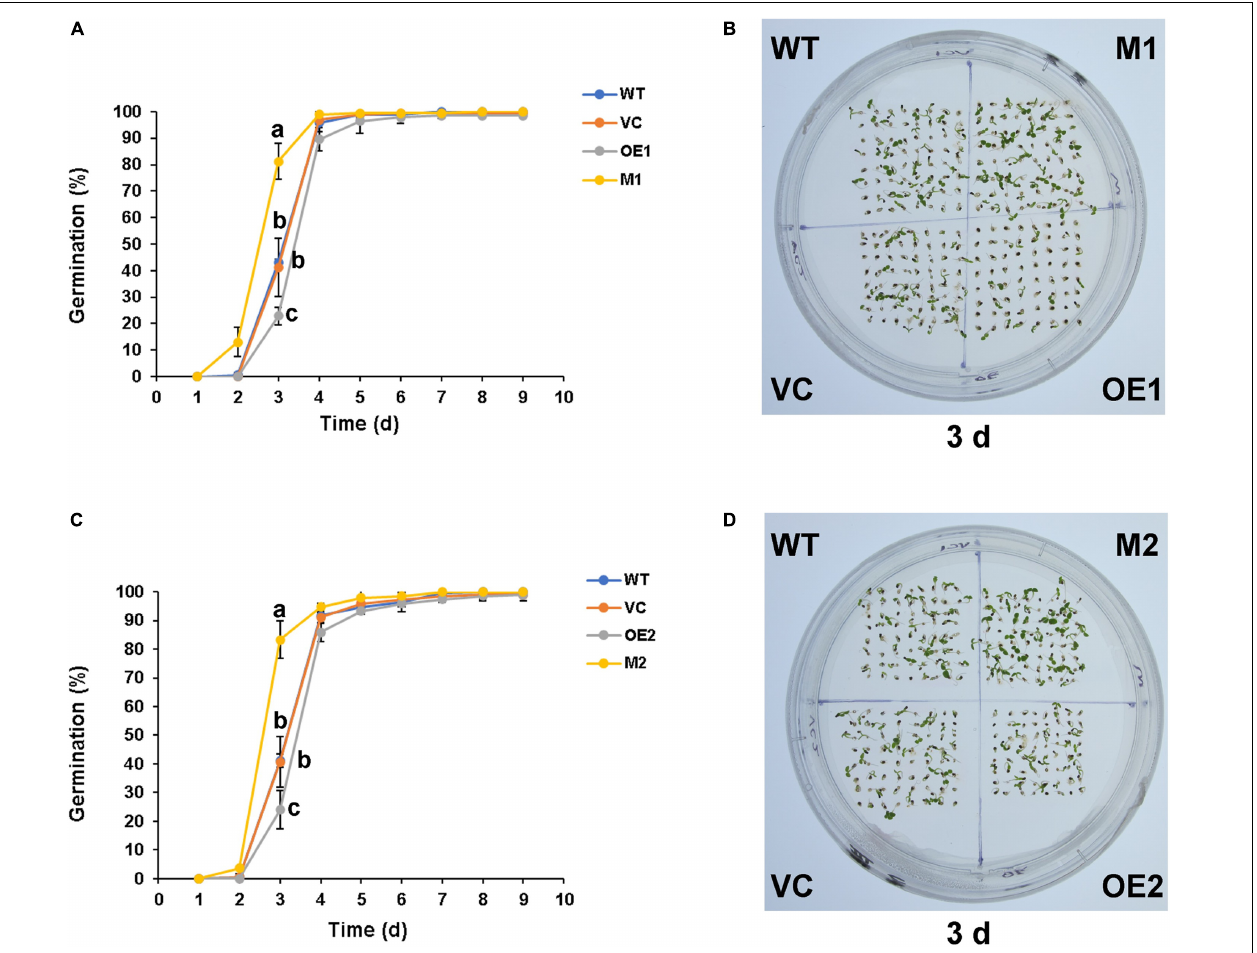
FIGURE 8 | Seed germination phenotypes of WT, VC, NtMYB330-OE lines and ntmyb330 mutant plants. (A,C) Seed germination percentages of WT, VC, NtMYB330-OE lines (OE1, OE2) and ntmyb330 mutant plants (M1, M2) in nine consecutive days. Values are means of three independent replicates. Error bars denote standard deviations. Different letters indicate statistically significant differences at P < 0.05 according to Tukey’s HSD test. (B,D) Seedlings of WT, VC, NtMYB330-OE lines (OE1, OE2) and ntmyb330 mutants (M1 and M2) grown on 1/2 MS medium for 3 days. The entire experiment was repeated three times, representative data from one experimental replicate presented